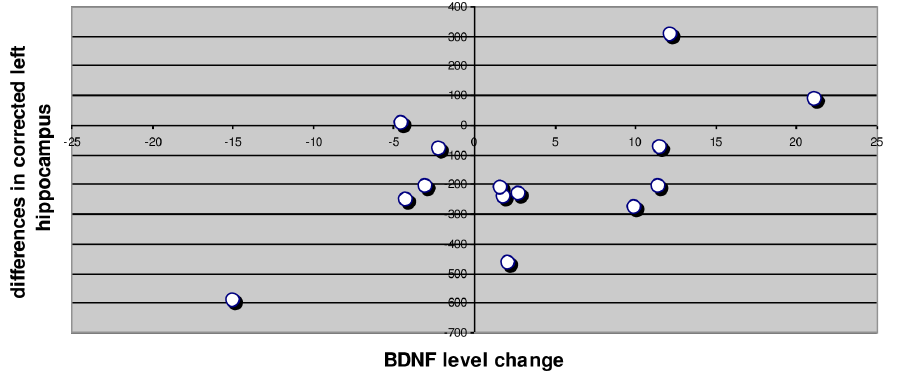
Figure 3. Differences in corrected left hippocampus and BDNF level change. Pearson r=0.597, p=0.024. Bootstrap: Sampling method single- Bias= 2 0.37, Std. Error=0.214, 95% Confidence interval 0.021 to 0.863.